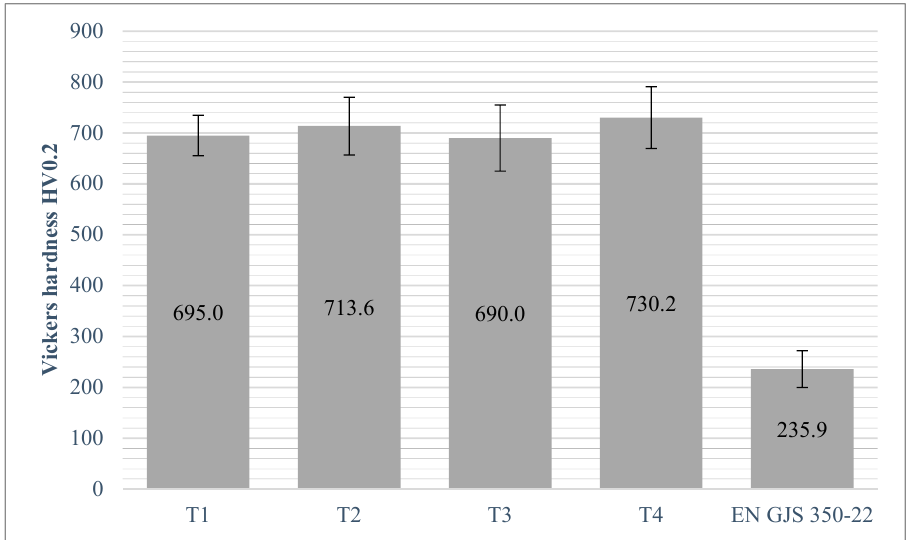
Figure 8. The average and standard deviation Vickers hardness of laser alloyed surface layers results (designation in accordance with Table 3).